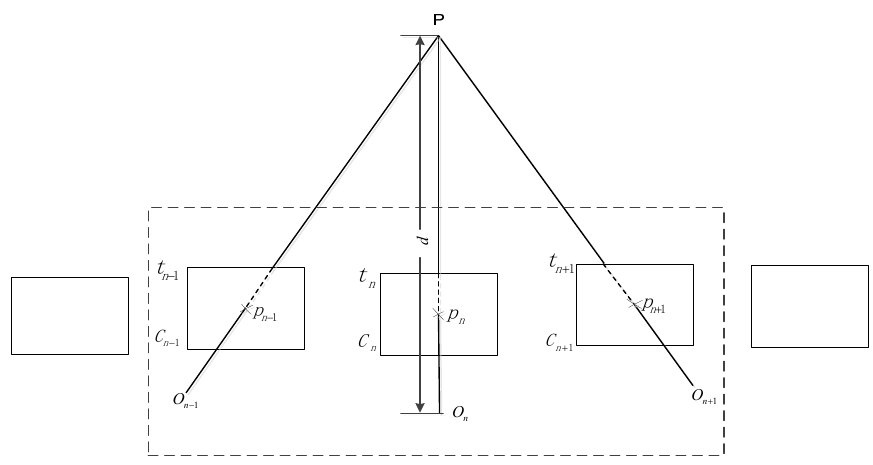
Figure 3. The enhanced scale drift free monocular VO system.